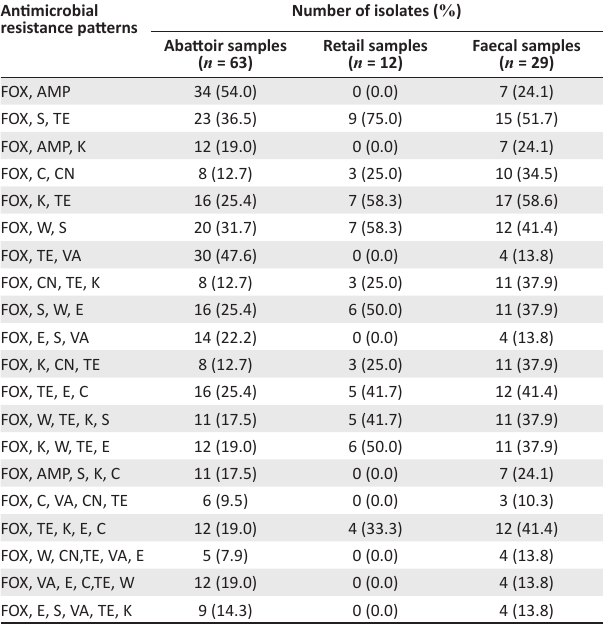
TABLE 3: Multiple-drug resistance patterns of Staphylococcus aureus isolates. Antimicrobial resistance patterns